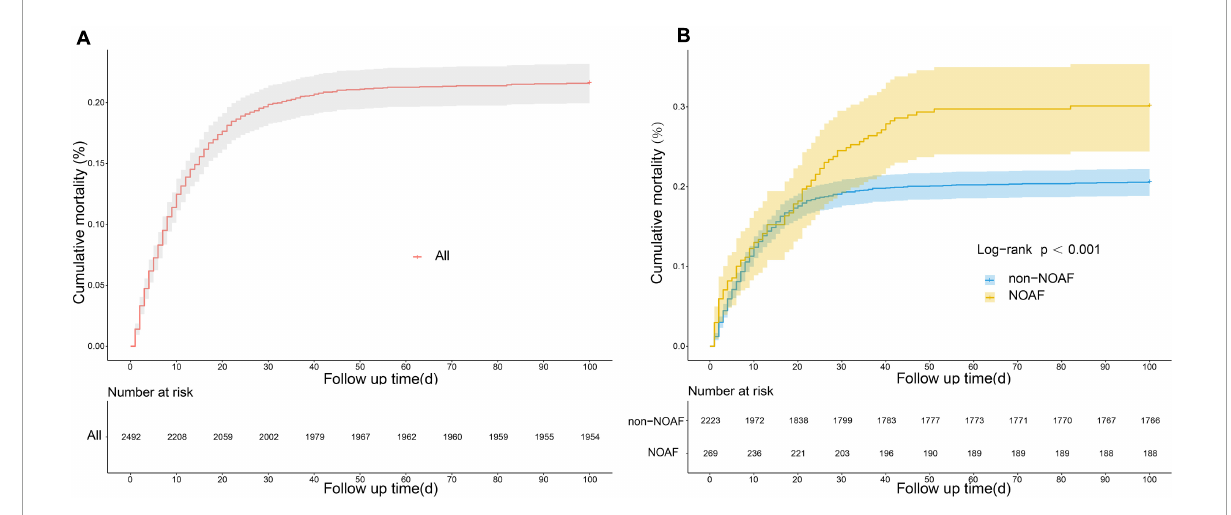
FIGURE7 Cumulative mortality in patients with sepsis based on kaplan-meier curves. (A) Cumulative mortality in all patients with sepsis. (B) Comparison of cumulative mortality between new-onset atrial fibrillation and non-new-onset atrial